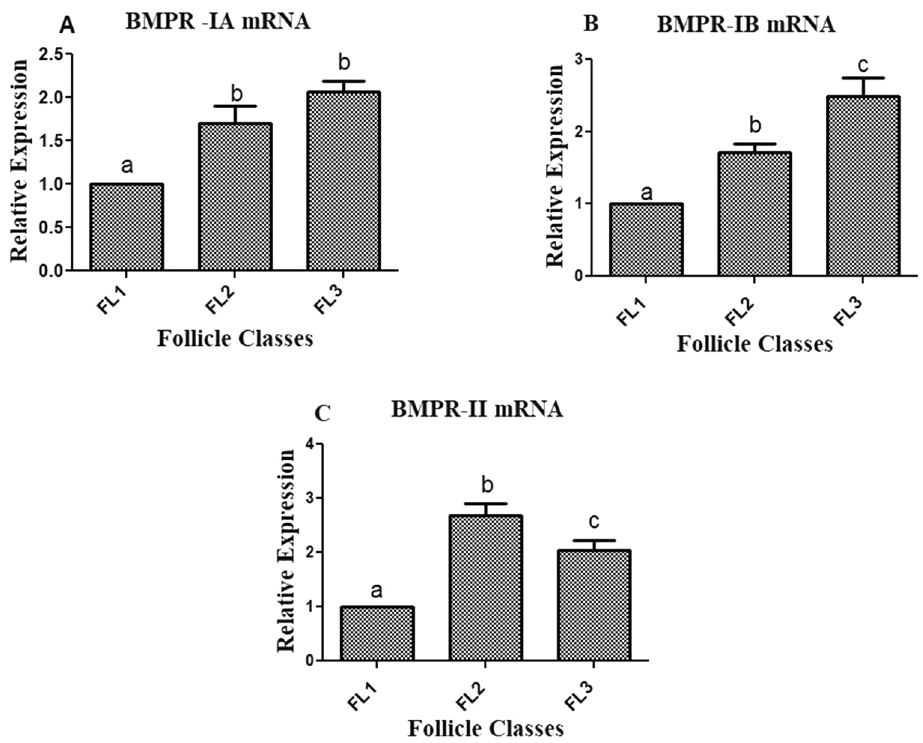
Figure 2. Transcriptional abundance of BMPRs (BMPR-IA, BMPR-IB and BMPR-II) in granulosa cells from different antral follicles of Goat (n = 6/group). All values are shown as mean ± SEM. Different superscripts denote statistically different values ( p < 0.05). Abbreviations: FL1, FL2 and FL3 denotes antral follicles of < 3 mm, 3–5 mm and > 5 mm diameters